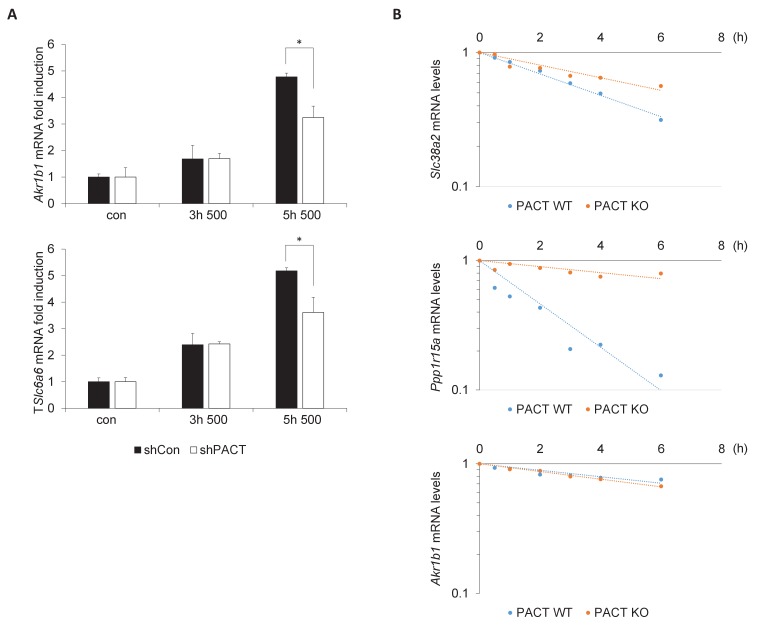
PACT influences the TonEBP-dependent adaptive transcription program.(A) MEFs deficient in PACT were treated with 500 mOsm hyperosmotic media for the indicated durations. Total mRNA was isolated, and target mRNA levels analyzed via RT-qPCR. (B) MEFs deficient in PACT were treated with 500 mOsm hyperosmotic media for 3 hr. Actinomycin D was added, and total mRNA was harvested after the indicated duration. mRNA half-life was calculated using linear regression analysis.